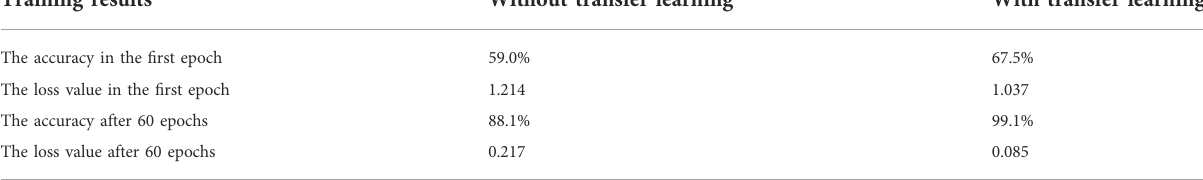
TABLE 4 Comparison of training results with or without transfer